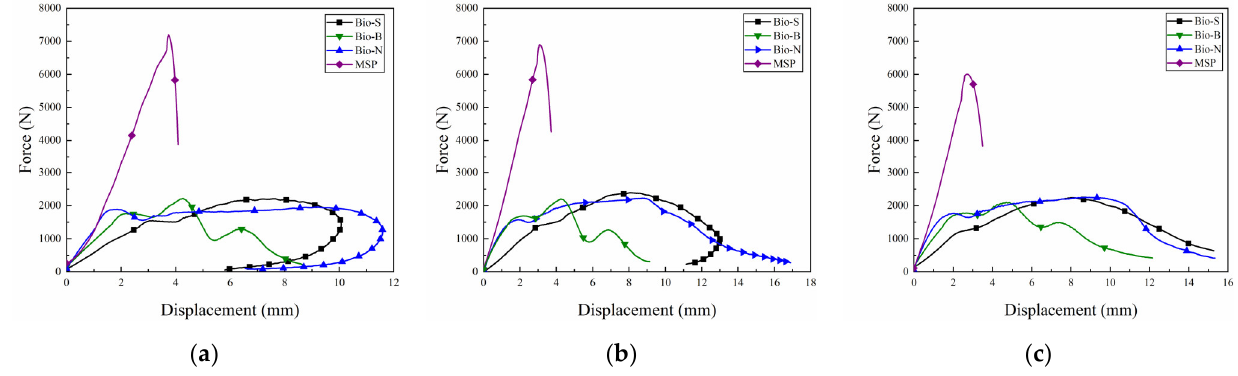
Figure 8. Three displacement curves of bionic composite plates under different impact energy levels: ( a ) 15 J; ( b ) 20 J; ( c ) 25 J.